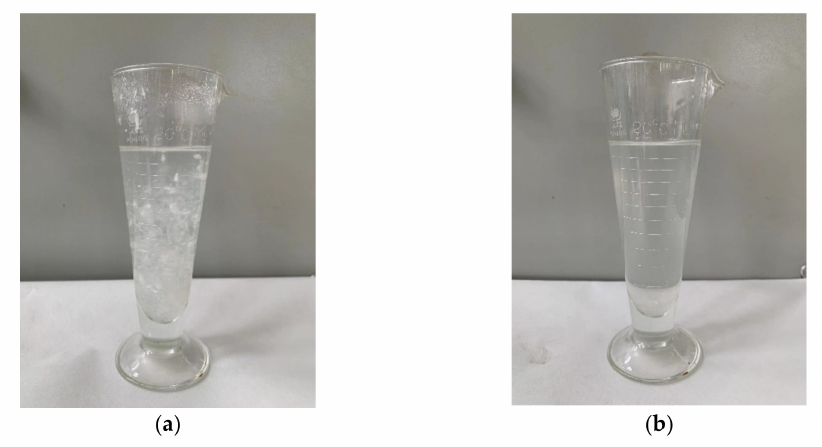
Figure 2. Preparation of stable PVA Solution for ( a ) PVA added and ( b ) PVA dissolution. The silica fume used in the test is gray powder with a median diameter of 3.57 µ m, average volume diameter of 1.75 µ m, and fineness of less than 1 µ m, accounting for more than 20%. It has high activity, and its basic physical properties are listed in Table 3. Table 3. Basic properties of silica fume used in the test.